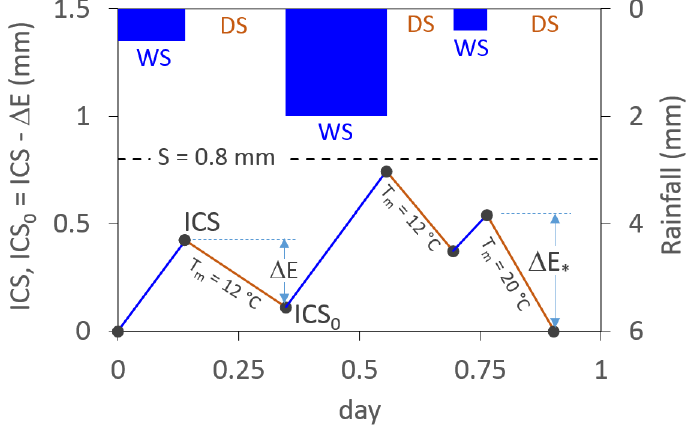
Figure 8. For a simple sequence of three WSs and DSs , interception loss during WS , and evaporation loss, ∆ E , during DS , with E 0 = S − ICS as initial condition. For the third DS , the condition described by Equation (21) occurs ( ∆ E > ICS ) and ∆ E ∗ = ICS .